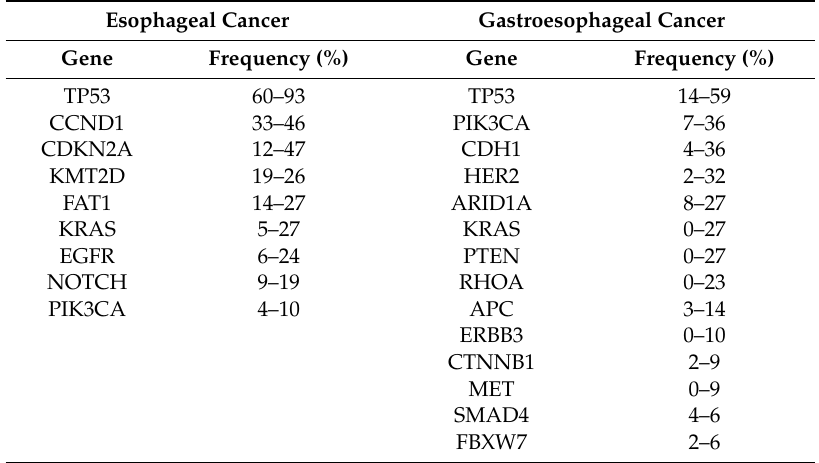
Table 4. Most recurrent genetic alterations in oesophagal and gastroesophageal